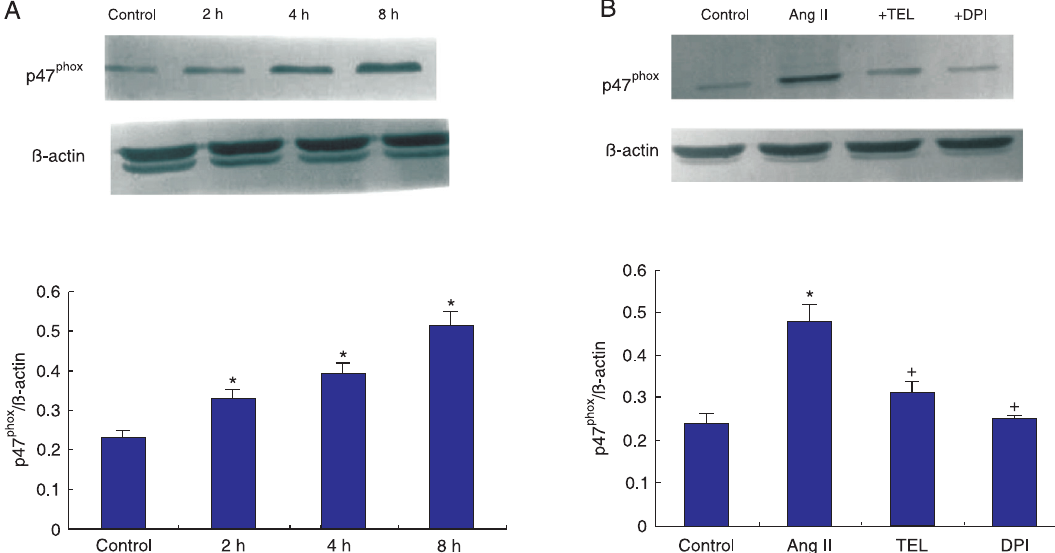
Figure 4. A, Angiotensin II (Ang II)-induced ROS generation was determined by DCFH-DA to DCF conversion, and results are reported as percent increase. Ang II-induced ROS generation reached the highest level (475 ± 42%, N = 5) at 15 min, which was greatly reduced by DPI. Serum-free controls showed no increase in fluoroscopic signal. Blockade of the AT 1 receptor by TEL reduced Ang II-induced ROS formation. ROS = reactive oxygen species; DCFH-DA = dichlorofluorescein diacetate; DPI = diphenyleneiodonium; TEL = telmisartan. *P < 0.01 vs control group; + P < 0.05 vs Ang II group (Bonferroni